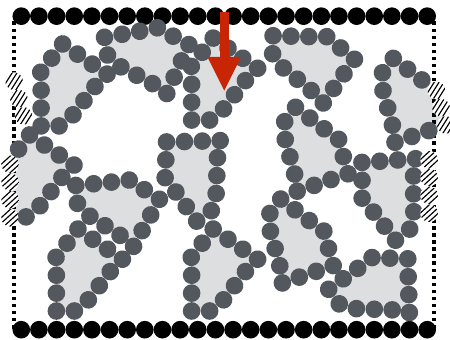
Figure 4. Boundary conditions used in the present study. The grains (medium gray) are compressed between two plates composed of spheres (black): the bottom plate is fixed and the top plate is moving down with a constant velocity V plate . Periodic space was used in the horizontal directions. Elements (hatched) crossing the periodic cell limits (dotted lines) appear on the opposite side of the samples. Note that this figure represents a 2-D simulation for clarity purposes, but the simulations performed are